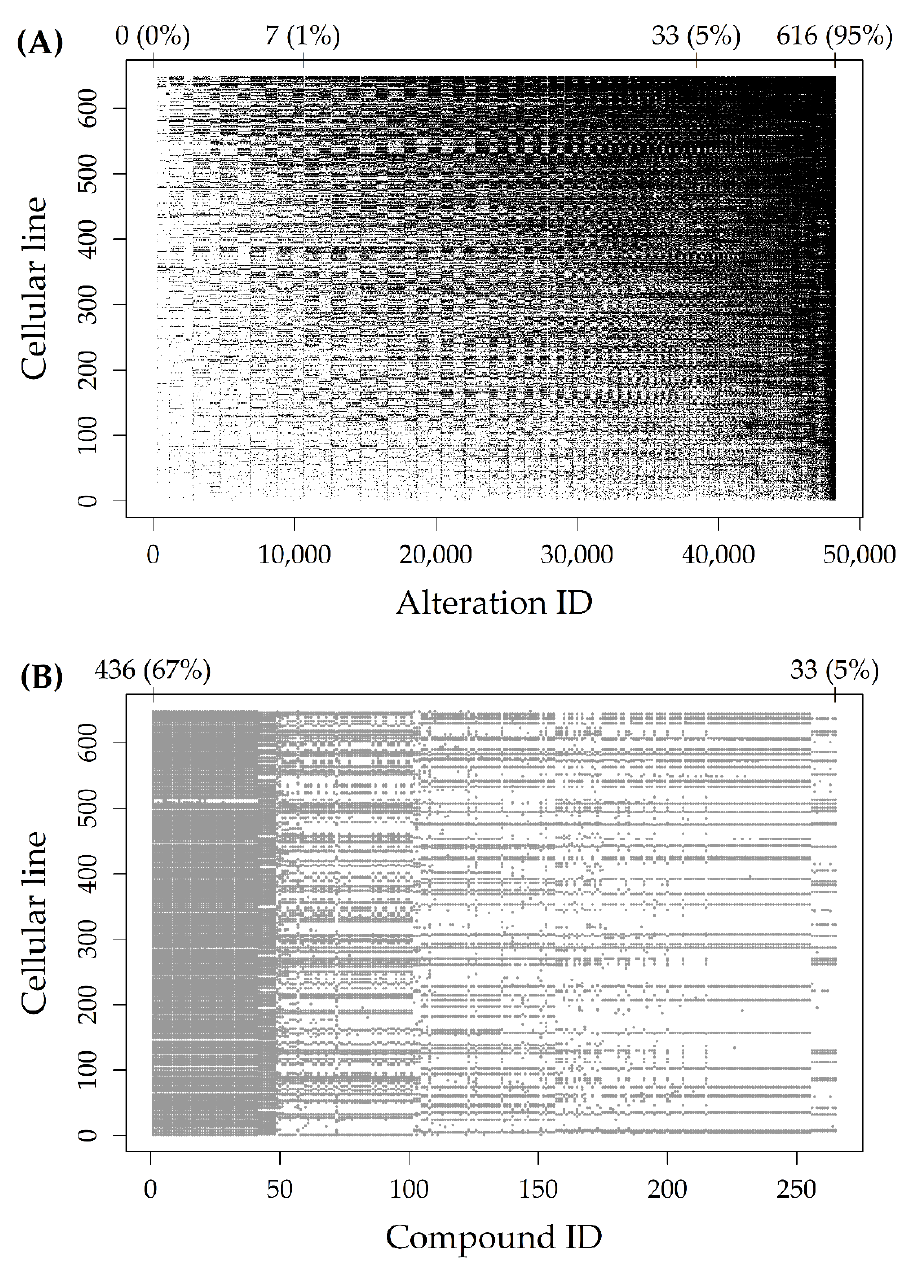
Figure 1. ( A ) Alteration dataset with the 48,270 rows (alteration types, reported on the x -axis) and the 648 columns (cell lines, reported on the y -axis) in increasing order of alteration frequency. Black dots indicate altered cells. Frequency (percentages) above the plot indicate row positions at which those alteration frequencies are reached for the first time; ( B ) Response dataset with the 265 rows (compounds, reported on the x -axis) in increasing order of sample size, and the 648 columns (cell lines, reported on the y -axis) in increasing order of alteration frequency. Grey dots indicate missing AUCs. The two frequencies (percentages) above the plot indicate the largest and smallest number of missing AUCs, respectively.